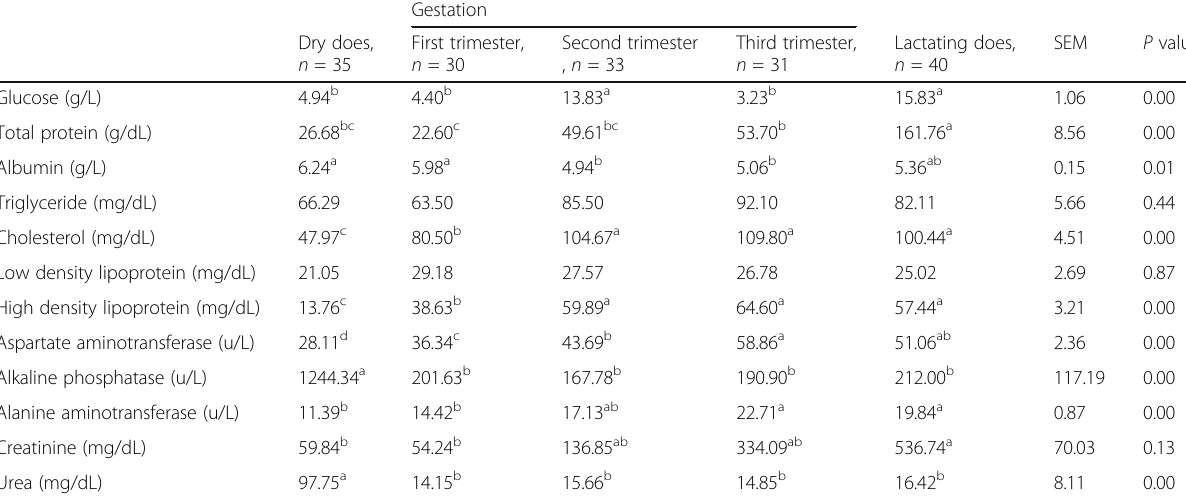
Table 1 Serum biochemistry of WAD goats at different physiological stages